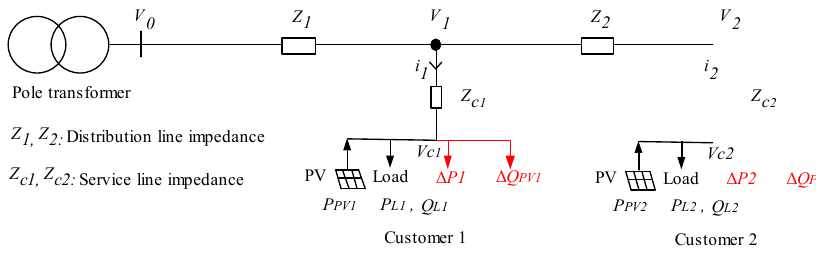
Figure 5. Over-voltage regulation using customer flexible resources.